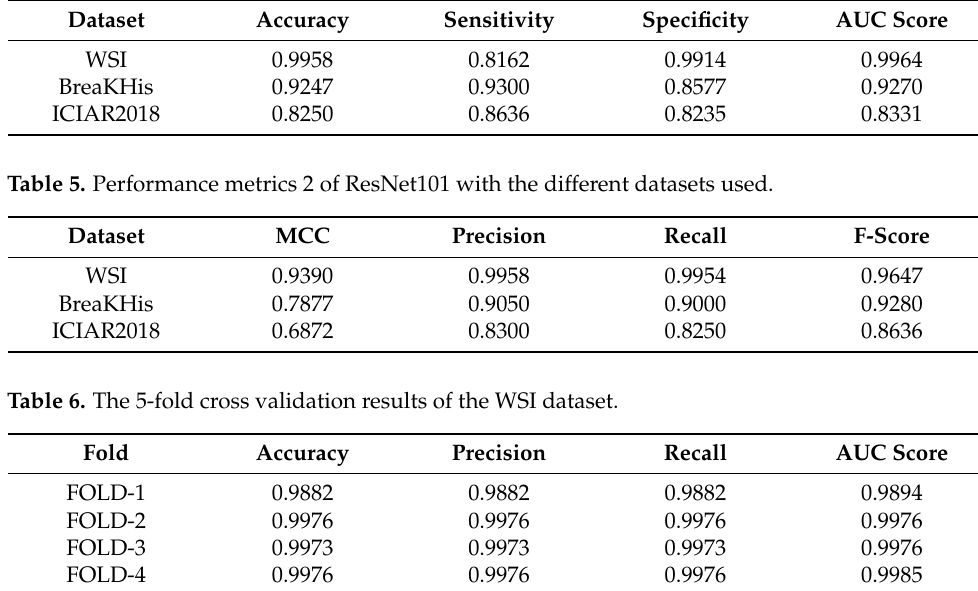
Table 4. Performance metrics 1 of ResNet101 with the different datasets used.